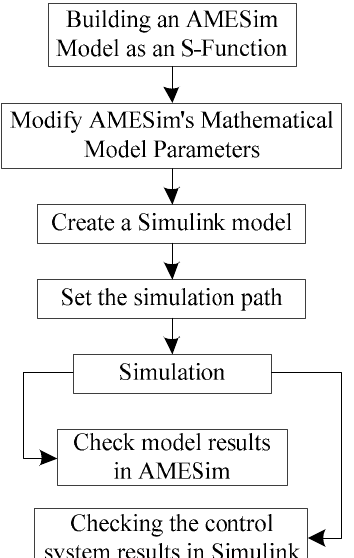
Figure 2. AMESim and Simulink Co-simulation Flow.